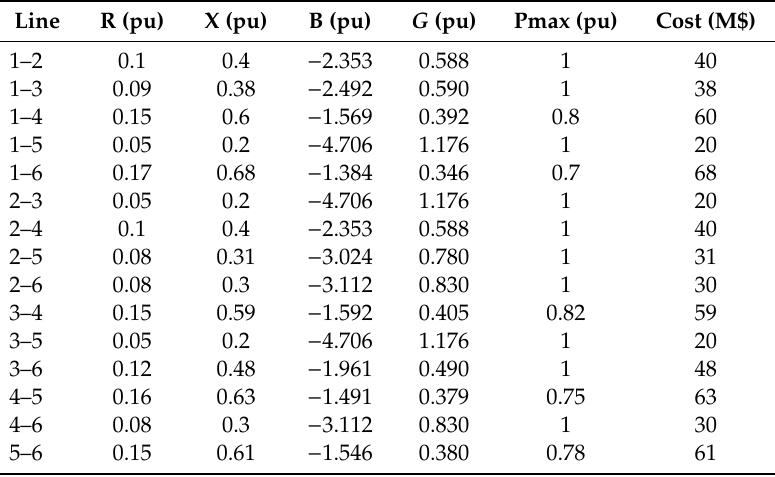
Table 2. Line parameters for Garver six-bus system.